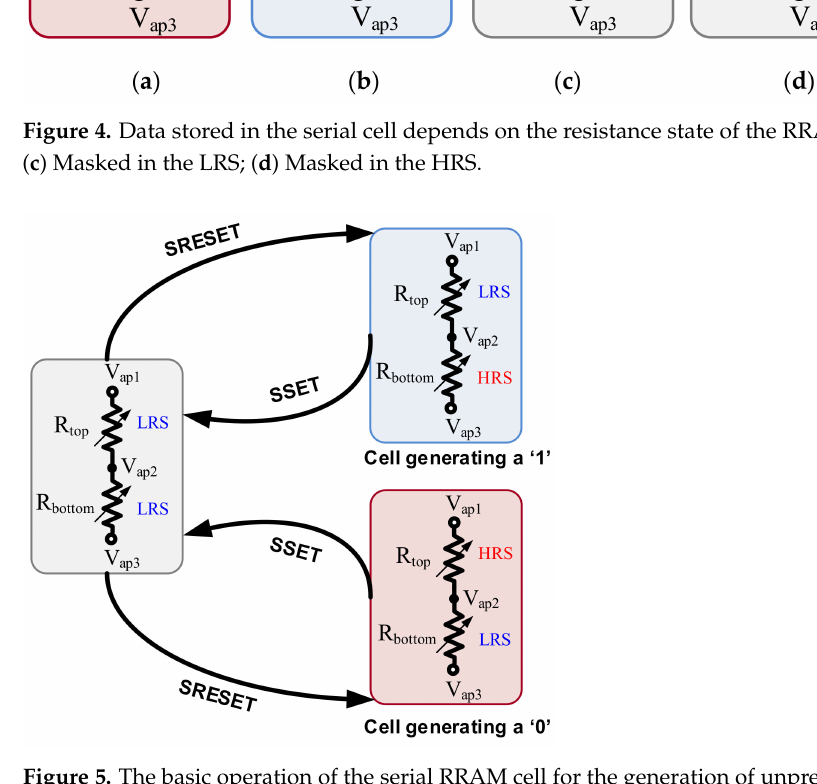
Figure 5. The basic operation of the serial RRAM cell for the generation of unpredictable